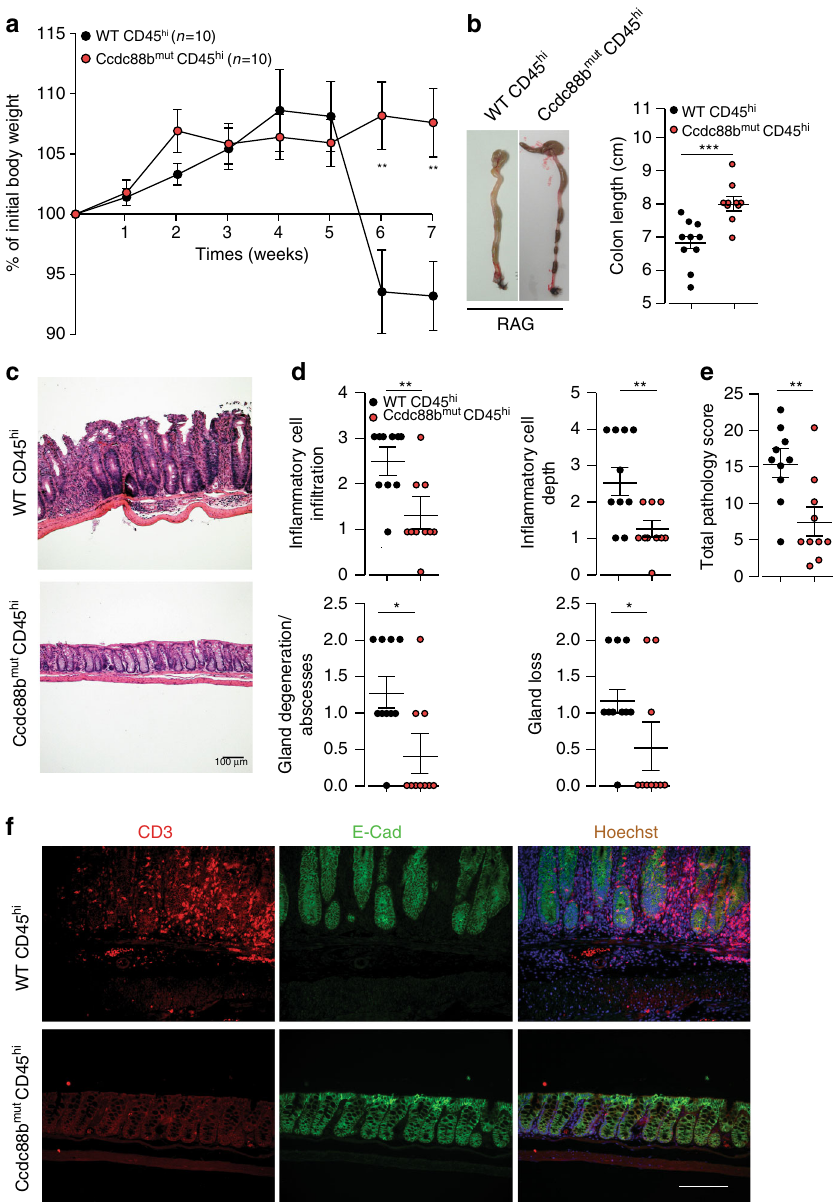
Fig. 4 T cell – driven intestinal in fl ammation is attenuated in the absence of Ccdc88b. CD4 + CD25 − CD45RB Hi T cells (4 × 10 5 ) from WT (WT CD45 hi ) or from Ccdc88b mut (Ccdc88b mut CD45 hi ) mice were transferred into Rag1 − / − and mice were monitored for appearance of clinical symptoms. a Weight of mice expressed as percentage of initial weight (mean ± SEM; ** P < 0.01, two-tailed Student ’ s t -test) ( n = 10 mice per group, data are pooled from 2 independent experiments). b Representative images of colons from mice 7 weeks post-T cells transfer and measurement of colon length (mean ± SEM. *** P < 0.001, two-tailed Student ’ s t-test). c Hematoxylin and eosin (original magni fi cation ×10) staining of colon sections at week 7 after transfer. Scale bars100 µ m. d Indicated colon histology scores for Rag1 − / − mice having received either CD45 hi WT or Ccdc88b mut T cells at week 7, ( n = 10 per group; mean ± SEM. * P < 0.05, ** p < 0.01 Mann – Whitney test). e Total pathology score (0 – 36) (mean ± SEM. ** P < 0.01, Mann – Whitney test) and (Supplementary Table 1) for scoring details. ( a – e ) Data are pooled from 2 independent experiments. f Representative immuno fl uorescence images ( n = 3) of CD3 + T cells (red), E-cadherin (green) and nuclei with Hoechst (blue) of indicated Rag1 − / − mice at week 7 post-transfer. Scale bars, 50 μ (Supplementary Fig. 4a). eQTL analysis can be used to identify CCDC88B (Fig. 5b). If the genetic associations observed for this relevant variant:gene pairing among potential combinations of chromosomal region with CD on the one hand and CCDC88B SNPs mapped by GWAS and the adjacent genes 21 . Because genotype information was available for these individuals, we analyzed the possible effect of 11q13 SNPs near CCDC88B on expression of the gene in these PBMC cell populations. We noted sion, respectively) may be similar. Thus, we investigated a pos- an effect of several SNPs in this region on CCDC88B mRNA expression in CD14 + cells, with the top marker (rs146881600; p effect on CCDC88B expression in CD14 + cells, and strength of the = 0.0016) mapping at 6Kb from rs641168 and 32 Kb from